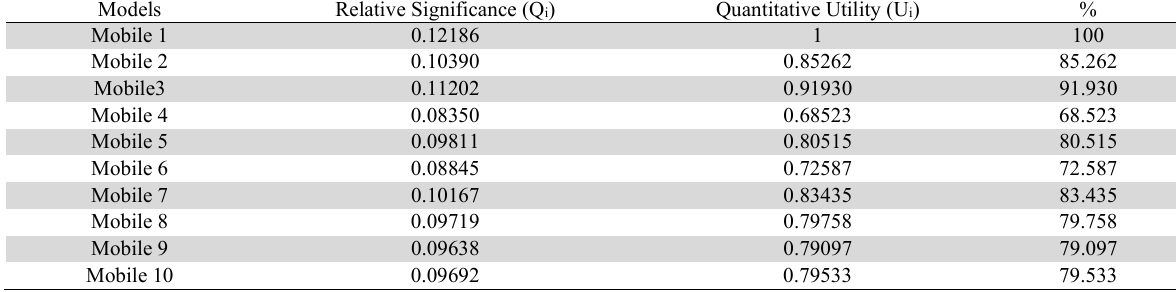
The Relative Significance and Quantitative Utility Values of Each Alternative